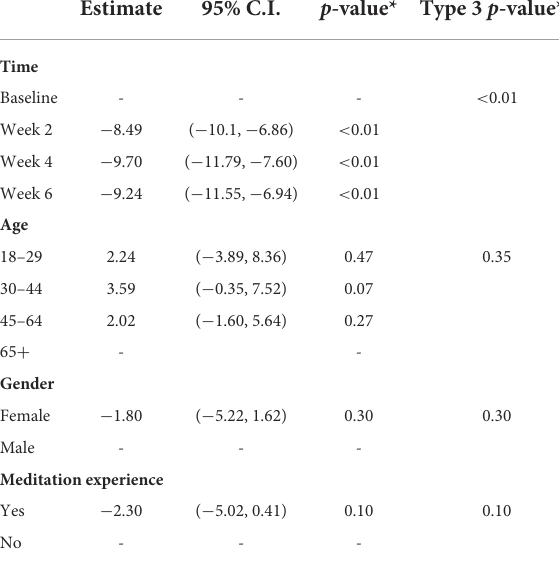
TABLE 4 From the mixed effect model, we observed the CES-D-10 score decreased 6.16 points on average from baseline to week 6 after adjusting with age, gender, and meditation experience ( p <